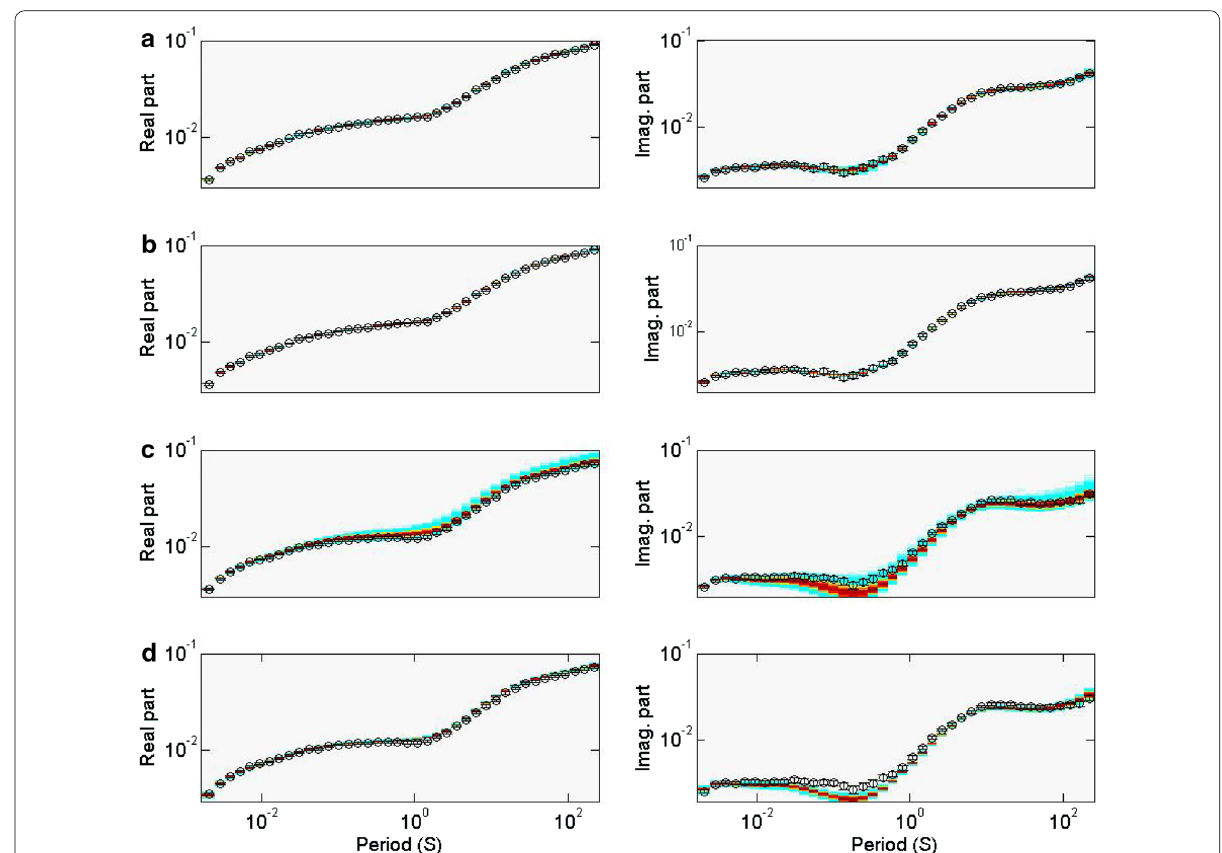
Fig. 2 Densities of the predicted data for the eight-layer model from the posterior samples for the inversions ( a , c ) with and ( b , d ) without considering error correlations. The upper panels are for the AR(1) parameter a represent the noisy synthetic